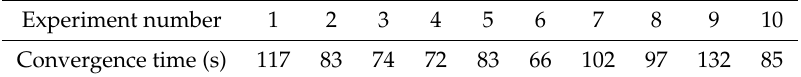
Table 4. Time to achieve global localization of AMCL.